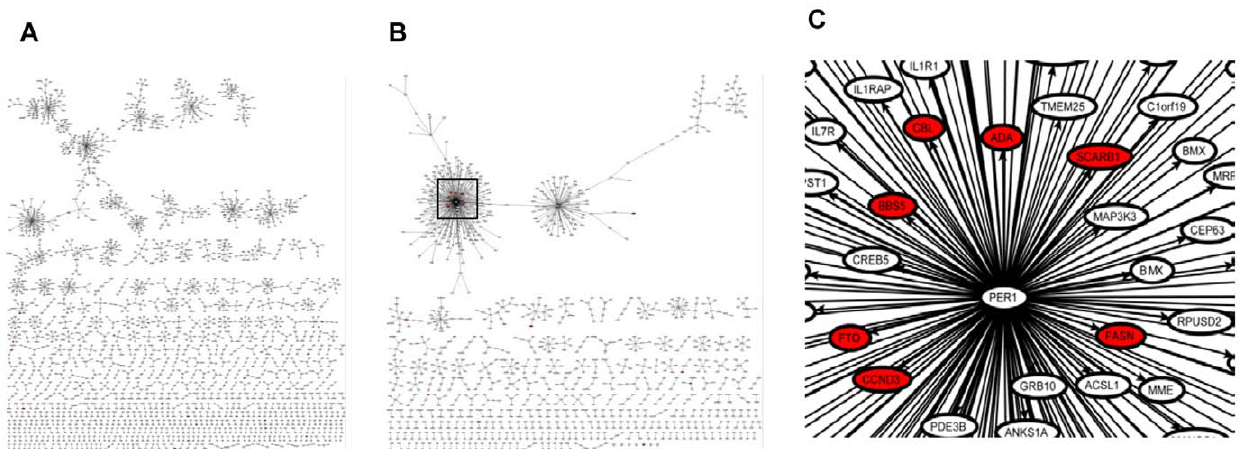
Figure 3. Fasted and fed Granger causality networks. (A) the global view of the fast network; (B) the global view of the fed network; (C) the zoom-in view of the subnetwork around PER1 (black box) in (B). There are more links in the fast networks. The fast network consists of many small subnetworks and the fed network consists of two large subnetworks and a few small ones. Nodes in red are obesity causal genes.